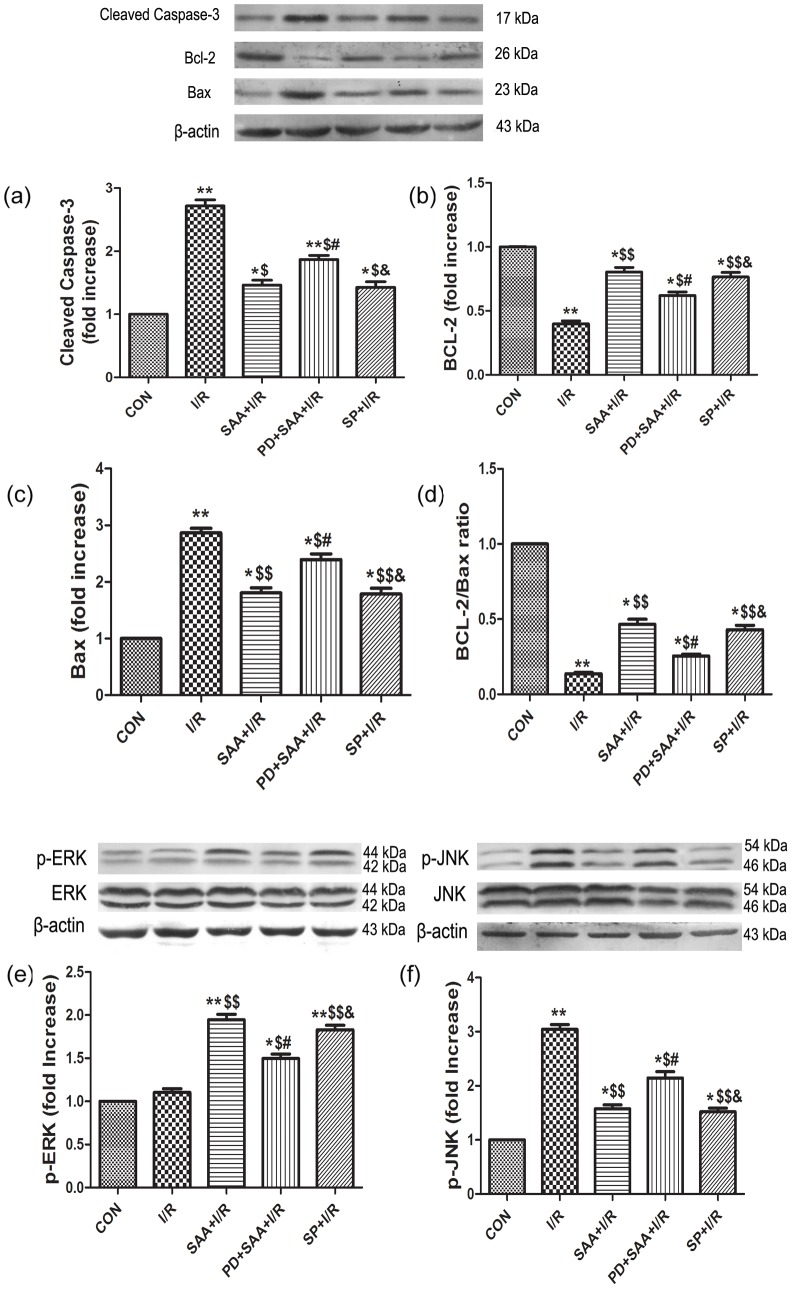
The effects of SAA and SP600125 on the expression of Bcl-2, Bax,caspase 3, Bcl-2/Bax, p-ERK1/2, p-JNK.a: caspase 3, b: Bcl-2, c: Bax, d: Bcl-2/Bax, e: p-ERK1/2(44 KDa, 42 KDa), f: p-JNK(54 KDa, 46 KDa). After 2 h reperfusion, the myocytes were harvested to detect protein expressions by western blot analysis. All data were expressed as mean ±SEM, n = 3, *P<0.05, **P<0.01 versus CON group, $P<0.05, $$P<0.01 versus I/R, #P<0.05, ##P<0.01 versus SAA+I/R, &P<0.05, &&P<0.01 versus PD+SAA+I/R.